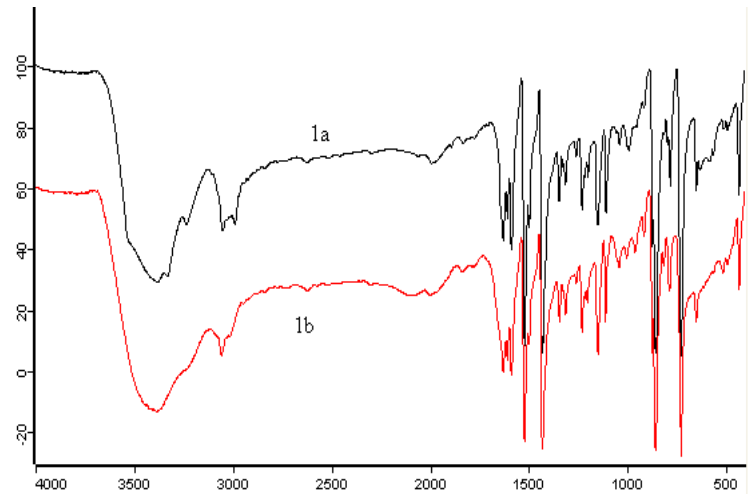
Figure 5. IR spectra of compound ( 1 ). ( 1a ) The original crystalline samples; ( 1b ) The residuum at 150.2 °C.